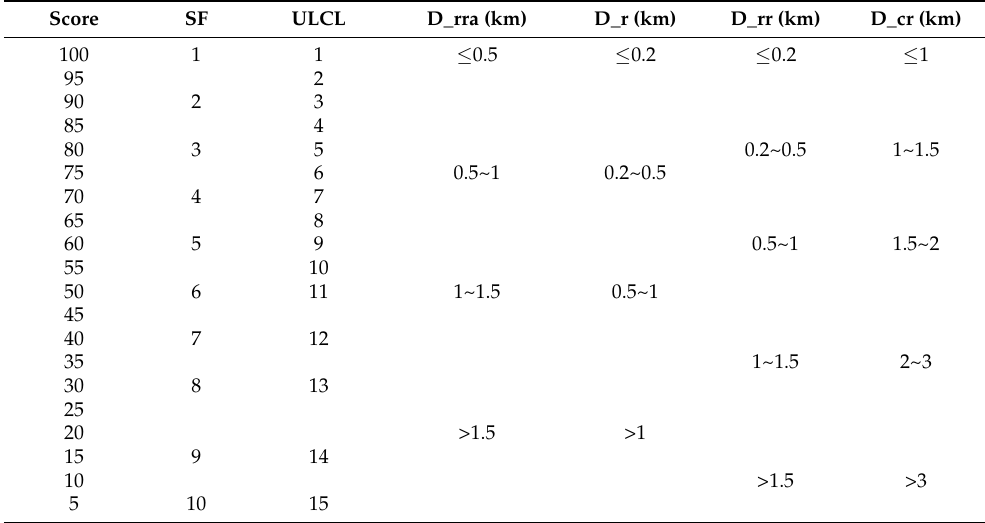
Table 3. Quantitative standard for evaluation index of cultivated land production function in Tongxiang City.